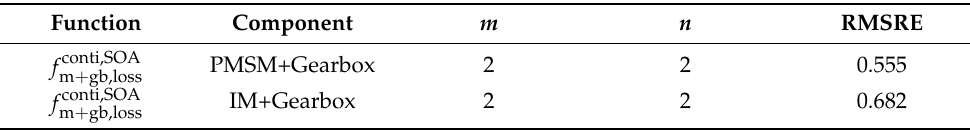
Table 2. Fitting parameters and results for the continuous low-order polynomial meta-models representing the state-of-the-art. The parameters m and n represent the polynomial order (coefficients m and n of Equation